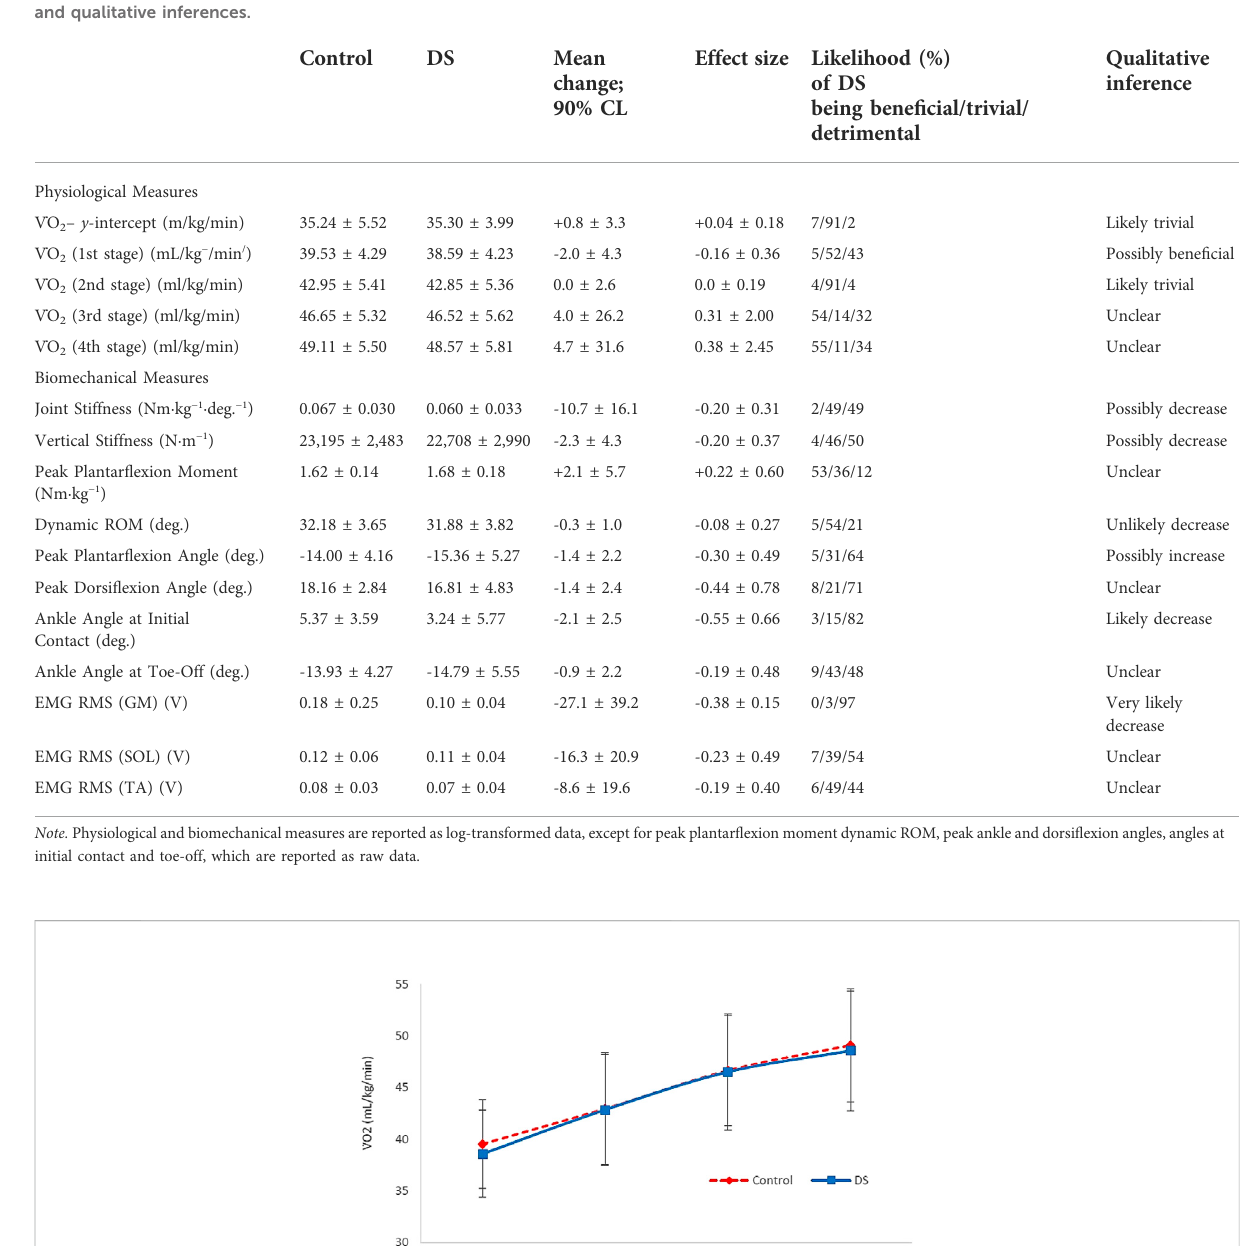
TABLE1Descriptivestatistics(mean±SD)andmeandifferencesinthecontrolanddynamicstretching(DS)outcomemeasuresalongwitheffectsizes and qualitative